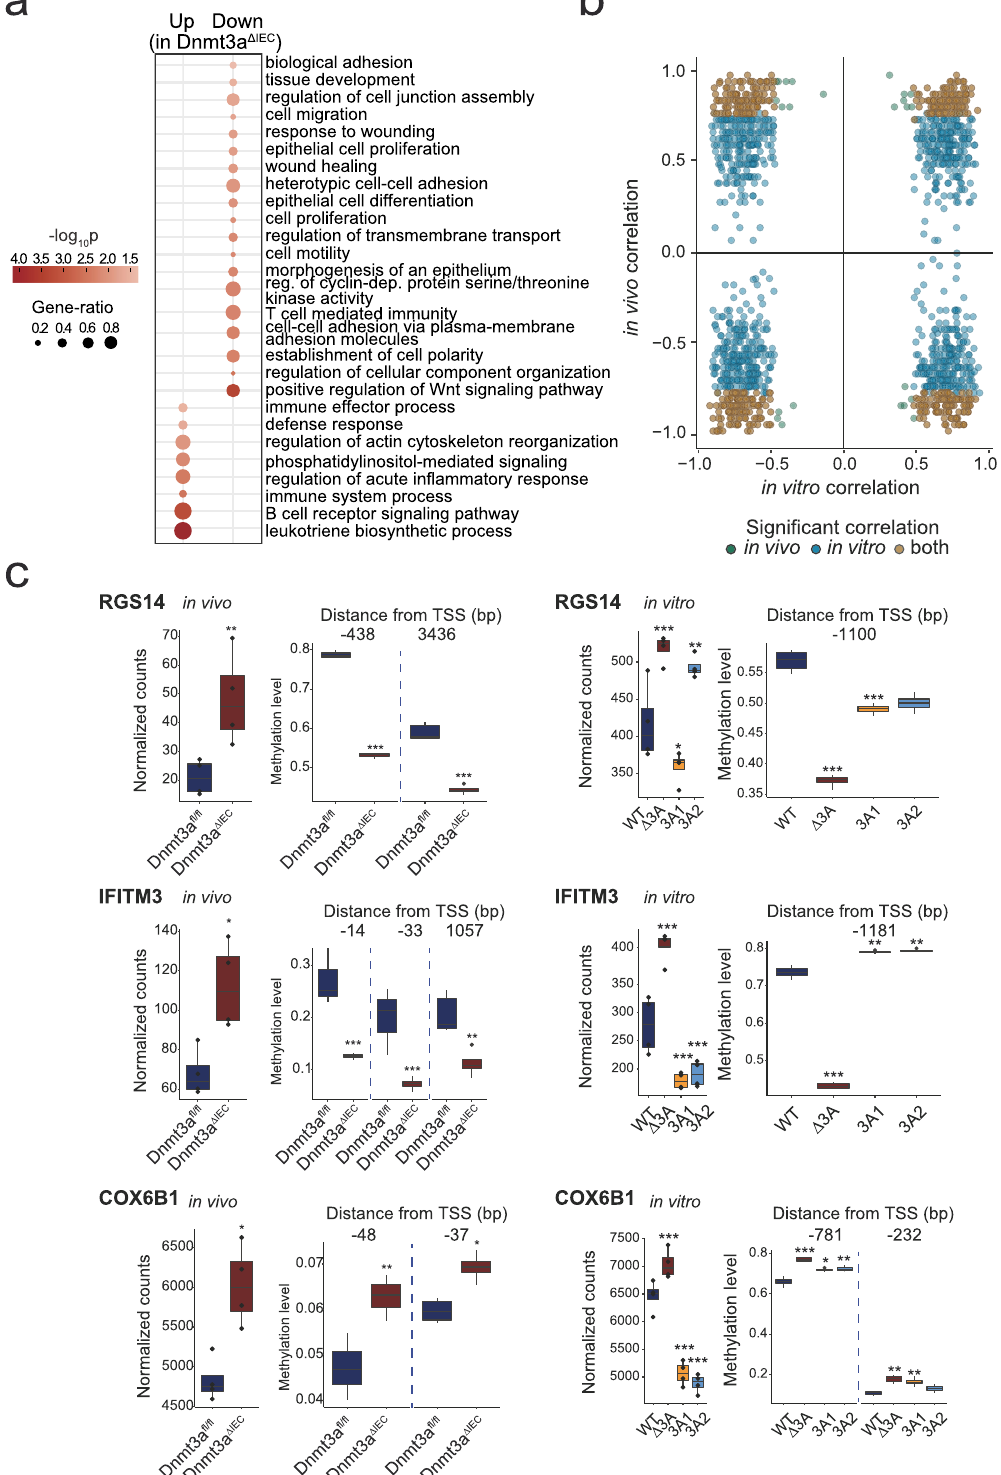
mouse model (in vivo). Gene expression (left panels) ( n =4) and DNA methylation levels (right panels) ( n =4) of RGS14 (Rgs14) , IFITM3 (I fi tm3) , and COX6B1 (Cox6b1) areshown.Withineachboxplot,thehorizontallinesdenotethemedianvaluesand theboxesextendfromthe25thtothe75thquartileofthedistribution.Thevertical lines extend to the most extreme values within 1.5 interquartile range of the 25th and 75th percentile of the distribution. P -values are calculated using the DESeq2 method for the transcriptomic data and the hierarchical linear model (limma) for the methylation data. * p <0.05, ** p <0.01, *** p <0.001, **** p